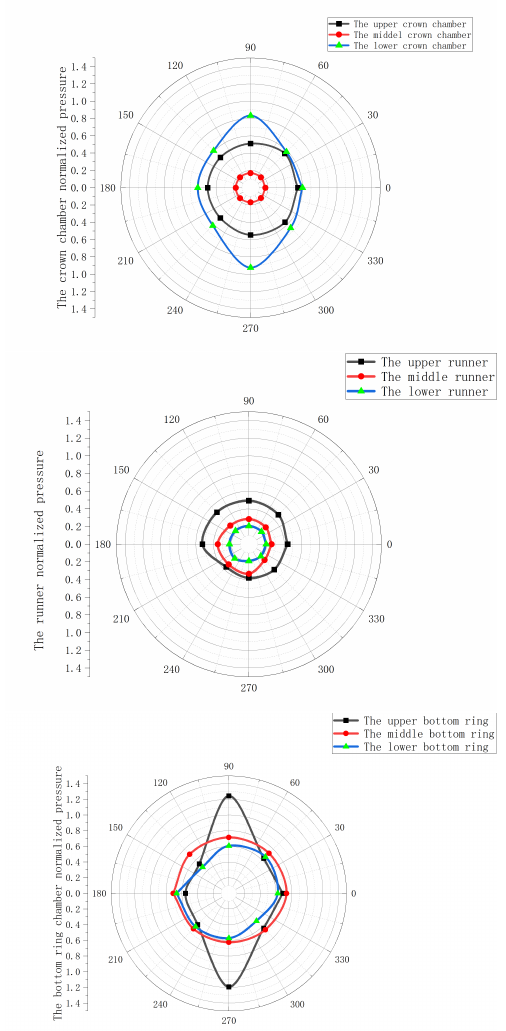
Figure 29. The polar graph of the three parts for the angle and pressure